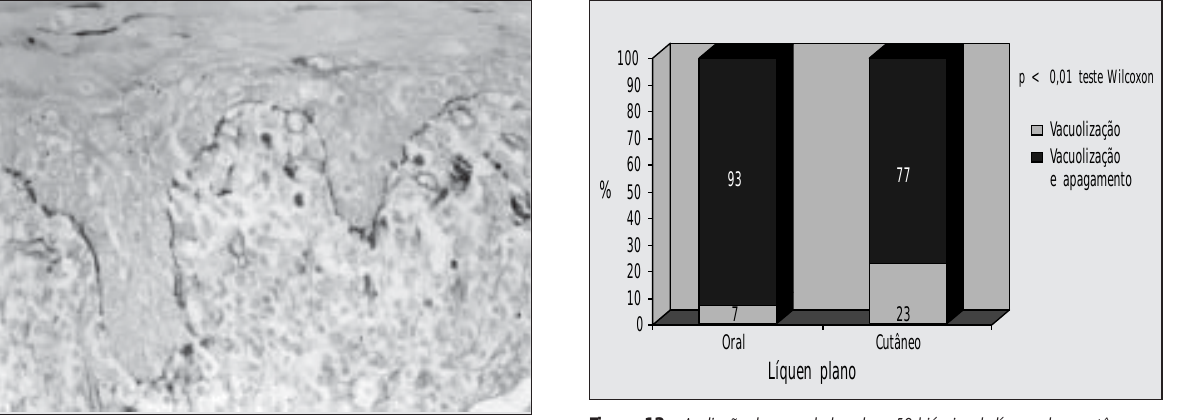
Figura 12 – Líquen plano oral. Focos de espessamento, fragmentação, afinamento e apagamento da membrana basal (PAS, aumento original 400x)